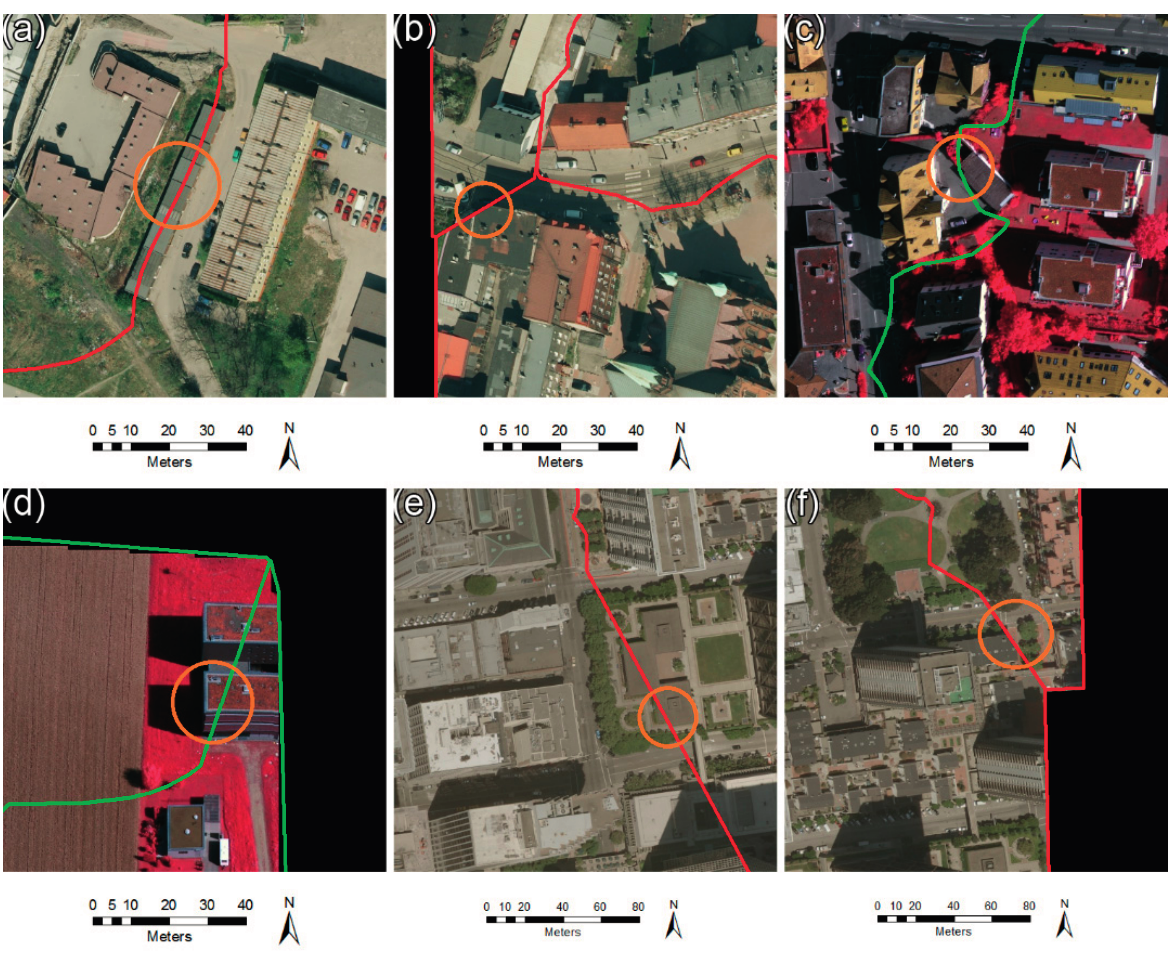
Figure 14. Visual discontinuities (marked by the orange circles) caused by the seamlines of the OESM-based method. ( a ) The low elevated objects that are passed through in Dataset 1; ( b ) the objects near the boundaries that are passed through in Dataset 1; ( c ) the low elevated objects that are passed through in Dataset 2; ( d ) the objects near the boundaries that are passed through in Dataset 2; ( e ) the low elevated objects that are passed through in Dataset 3; ( f ) the objects near the boundaries that are passed through in Dataset